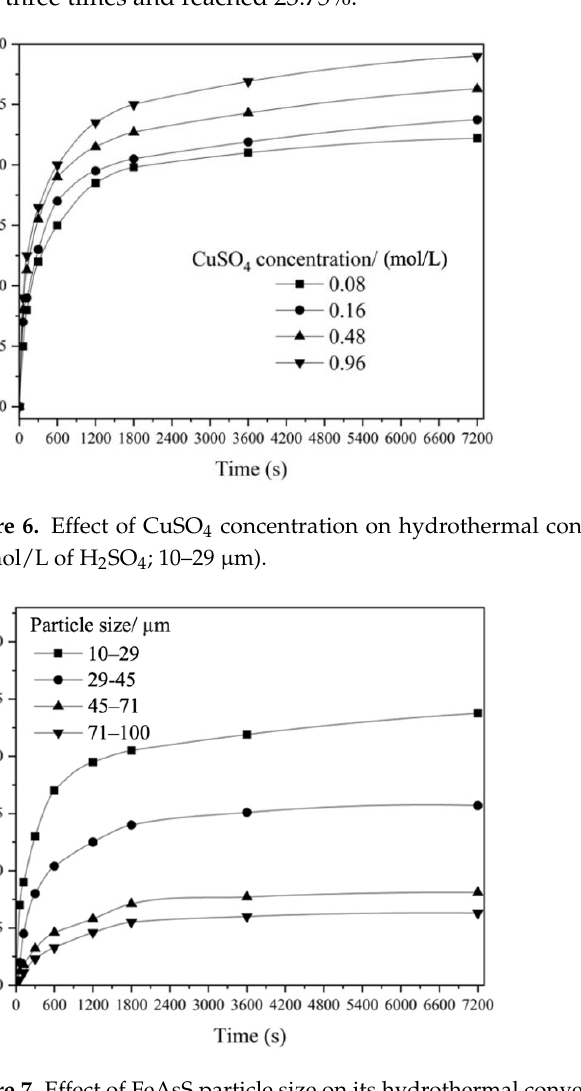
Figure 7. Effect of FeAsS particle size on its hydrothermal conversion (100 rpm; 503 K; 0.1 mol/L of H 2 SO 4 ; 0.16 mol/L of Cu).